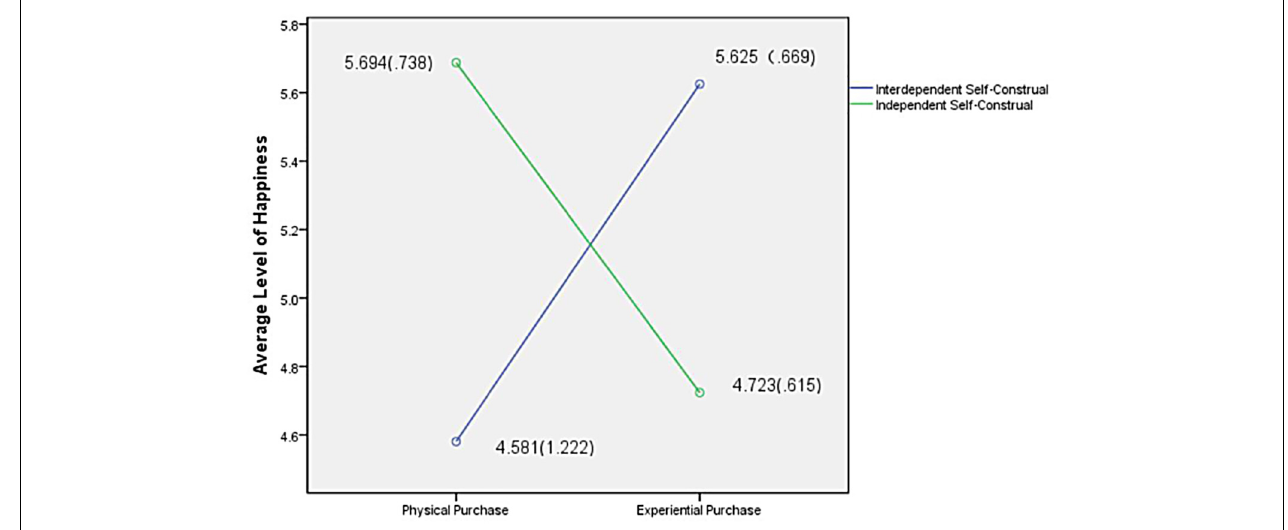
FIGURE 1 | Interaction between constructive style and consumption type.